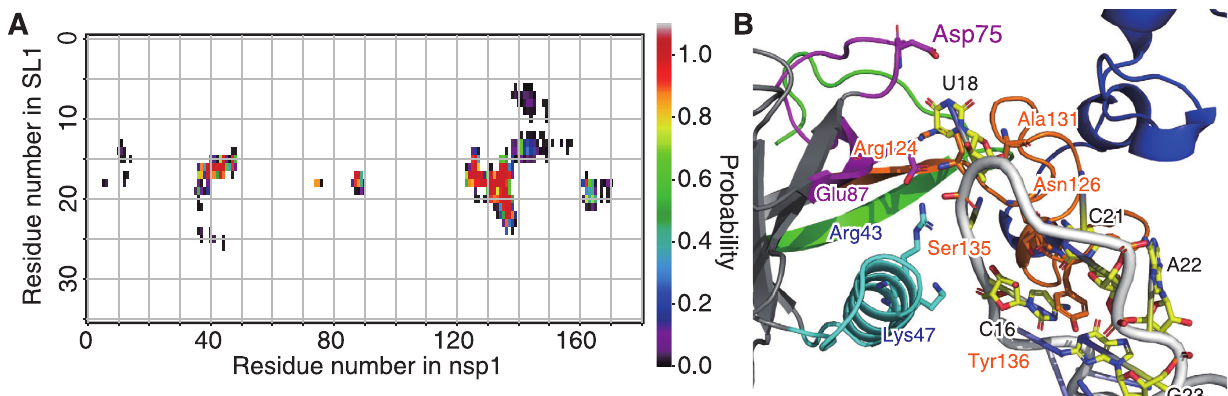
Fig 9. Interactions between nsp1 and SL1 observed in cluster 1. (A) Pairwise contact probability in cluster 1. See the legend to Fig 3. (B) Representative snapshot of the cluster 1. The interface regions (i) through (v) are shown as green, cyan, magenta, red, and blue ribbons. Bases 16–26 of SL1 are shown in